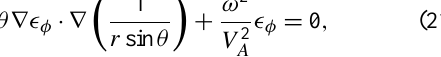
3 Eigenvalue solutions of the poloidal